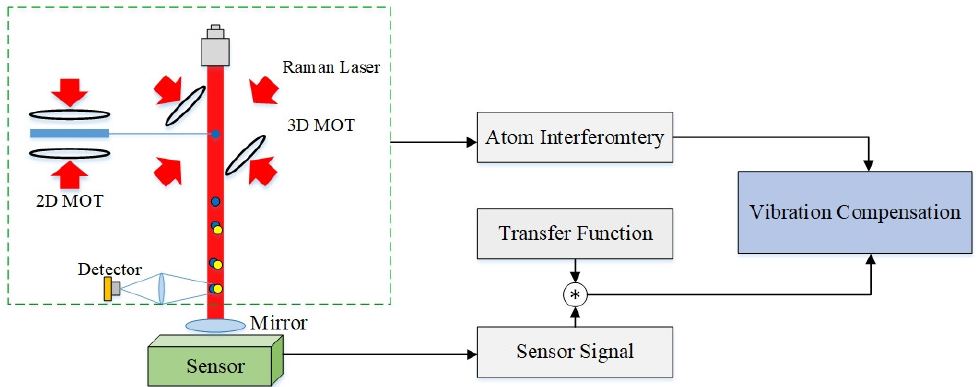
Figure 5. Vibration compensation scheme for an AIG.